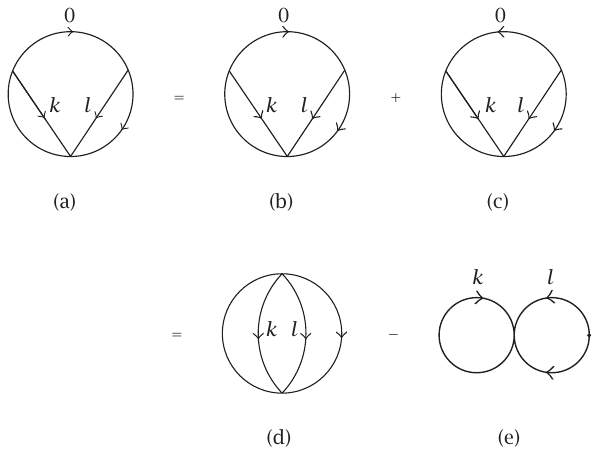
Figure 4.7 . Identity which proves that k and l can be exchanged when the upper propagator is zero. Diagram (c) is zero because no propagator goes into the upper right vertex. Diagram (e) is zero for the same reason at the right